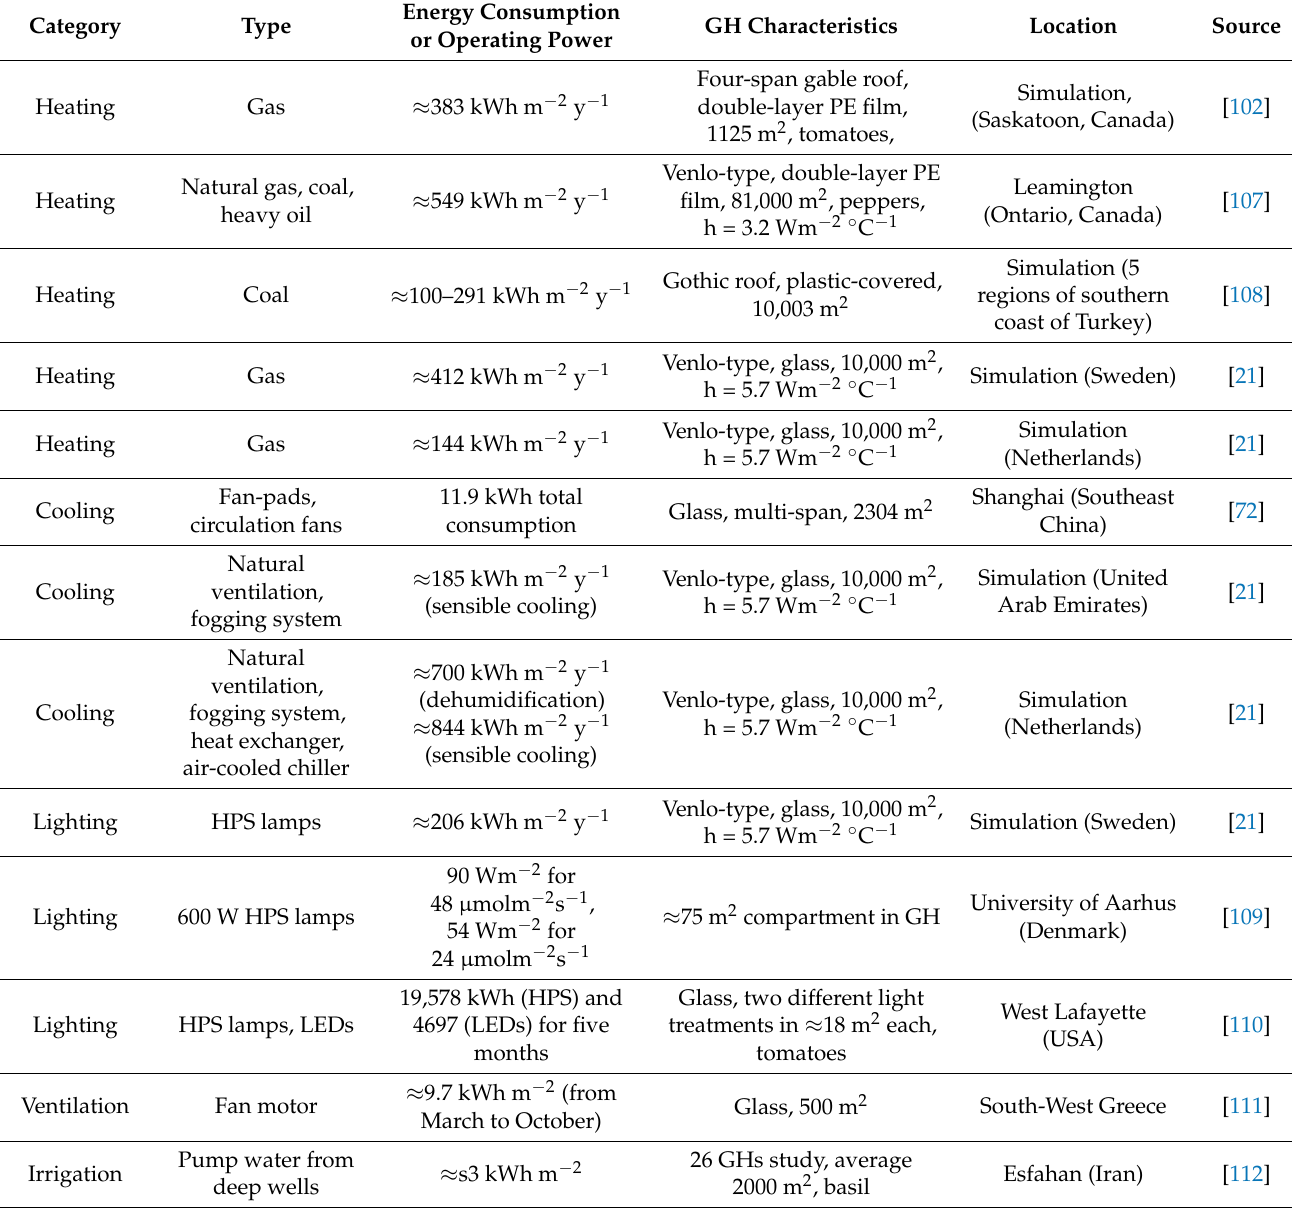
Table 1. Energy demand for operation systems of a